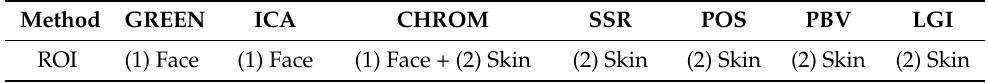
Table 2. ROI method of each rPPG